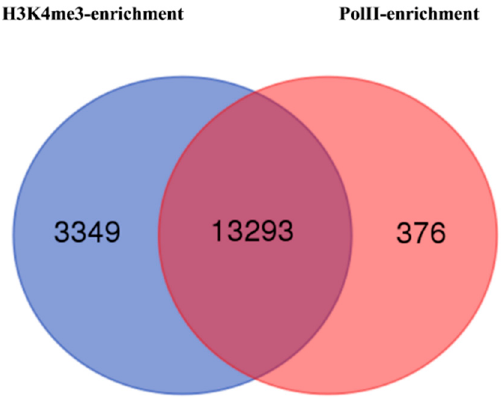
Figure 5. Venn diagram showing the intersection of H3K4me3 and PolII enrichments within genes in LR2. An extensive overlap of gene-associated H3K4me3 and PolII enrichments (log 2 FC > 0.6) in epiline LR2 compared with the control line is shown.